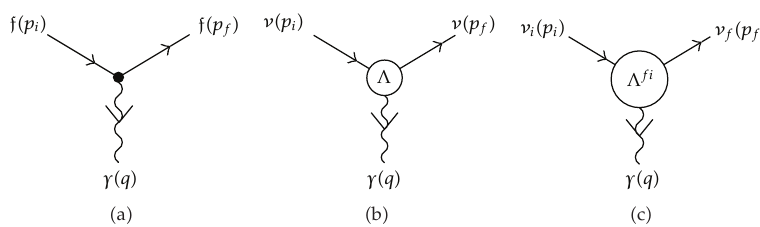
Figure 1: Tree-level coupling of a charged fermion f with a photon γ (cid:3) a (cid:4) , e ff ective coupling of a neutrino ν with a photon (cid:3) b (cid:4) , and e ff ective coupling of neutrinos with a photon taking into account possible transitions between two di ff erent initial and final massive neutrinos ν i and ν f (cid:3) c (cid:4)